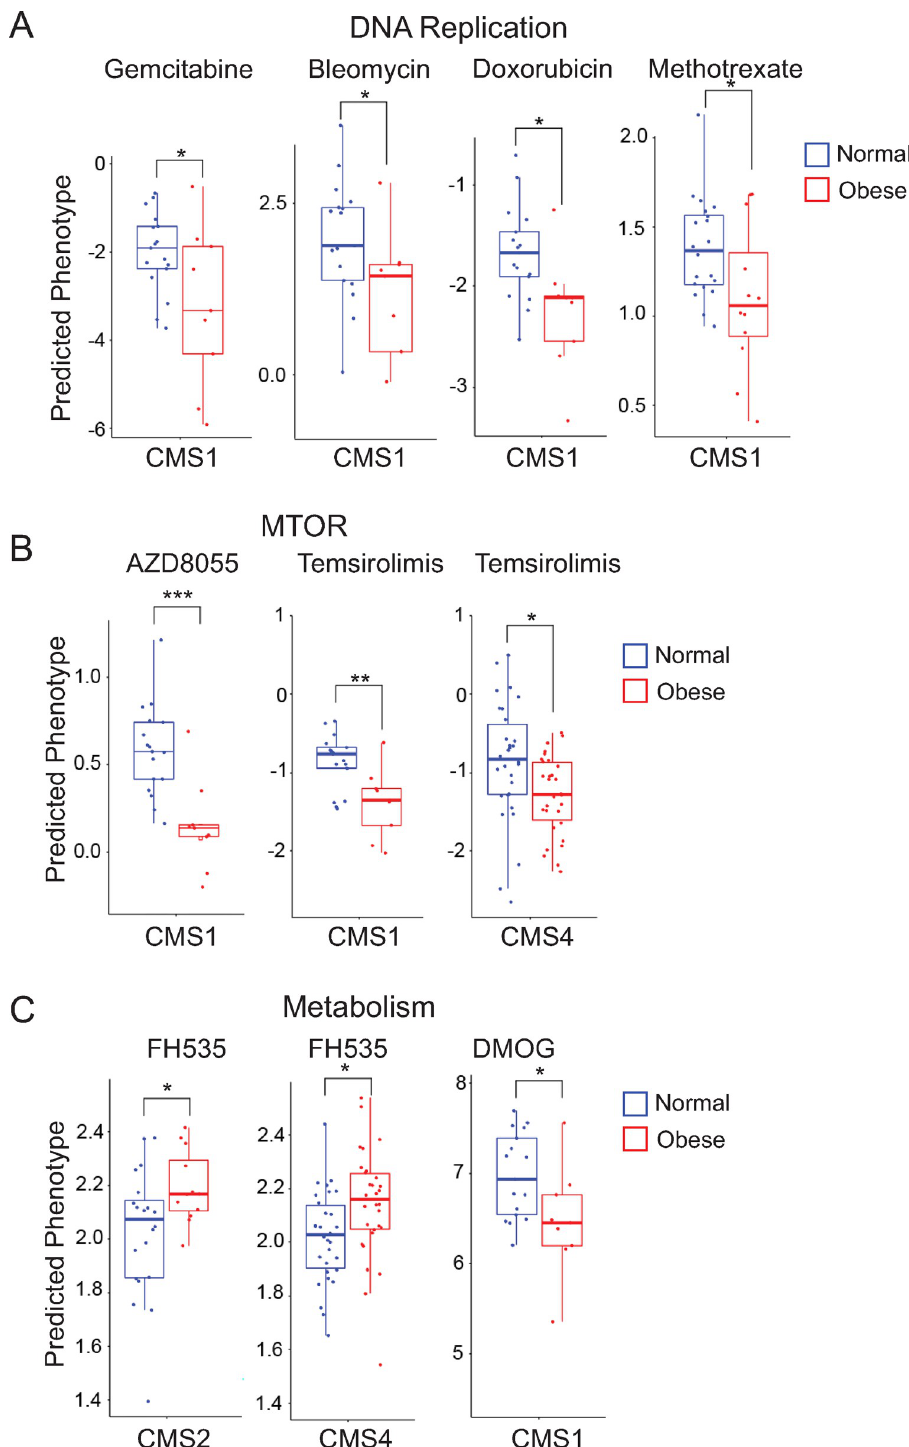
Fig 7. Predicted drug sensitivity analysis reveal CMS-specific differences between obese BMI groups. Estimated half maximal inhibitory concentration (IC50) of drugs targeting DNA Replication (A), MTOR (B), and Metabolism (C) for tumors from normal (blue) and obese (red) BMI patients across the CMS categories is shown. To assess predicted drug sensitivity, the pRRophetic R package was used with normalized RNA-seq counts. Box plots with p values from t-tests are